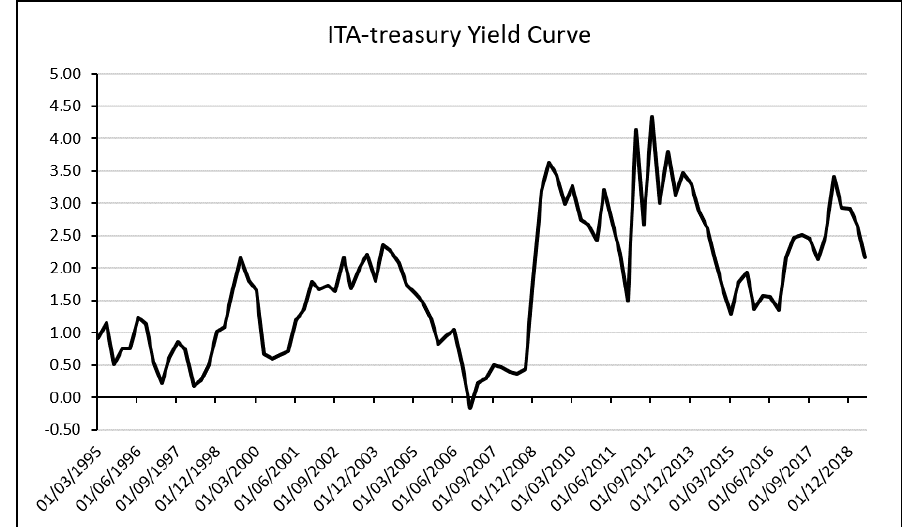
Figure 5. Yield Curve obtained by the difference between long-term and short-term treasury bill maturity for the period of 1995:Q1 to 2019:Q2. (data source: Bank of Italy, 2019, ‘own